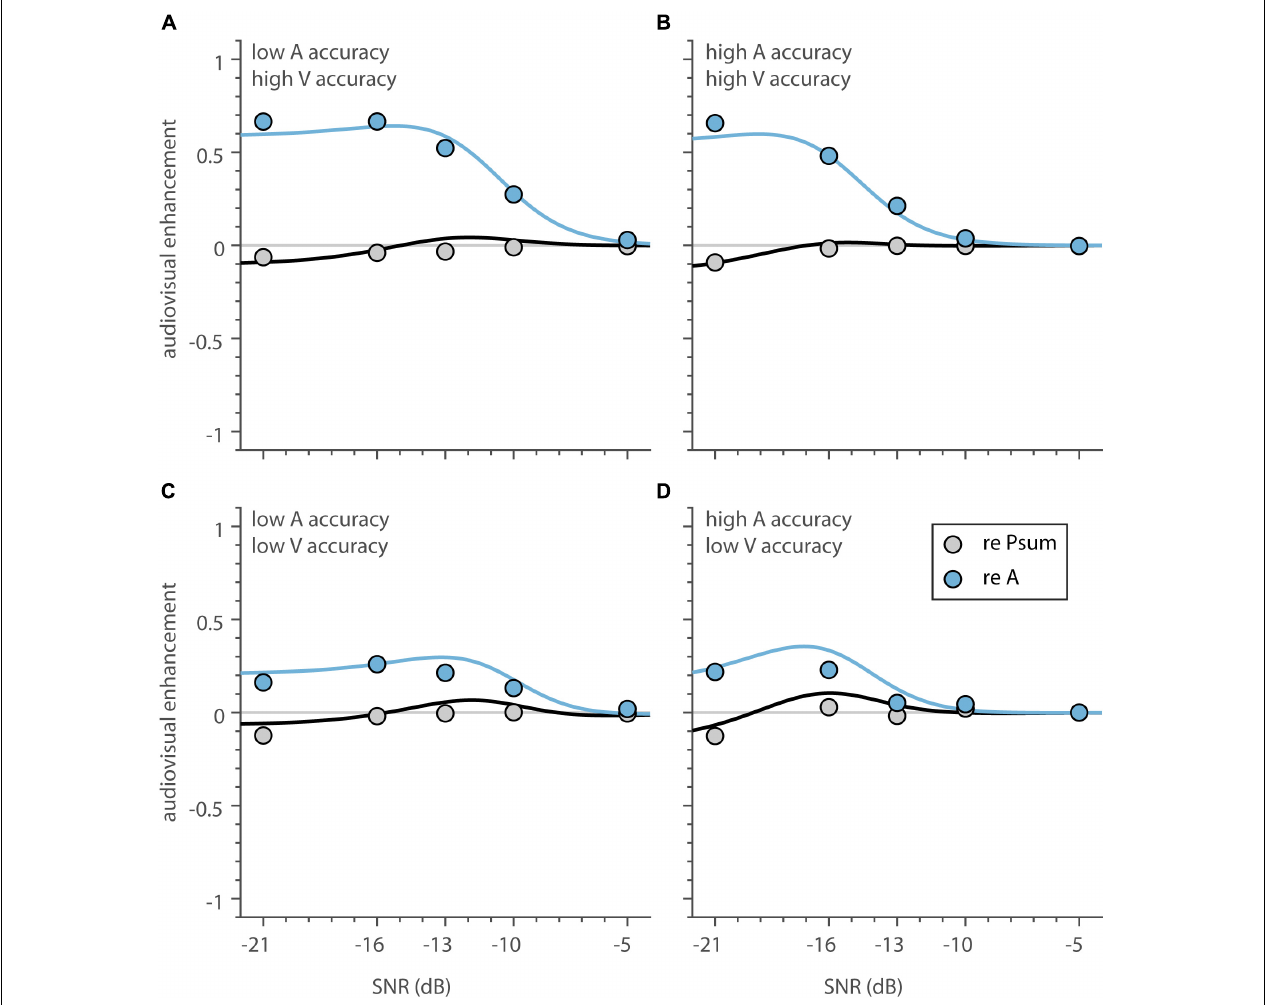
FIGURE 7 | Audiovisual enhancement as a function of SNR. (A–D) The average audiovisual enhancement, expressed as proportion correct, as a function of SNR, compared to speech listening only (blue) and the proportion summation model (black). Curves (circles) indicate the enhancement calculated from the average model estimate (average correct